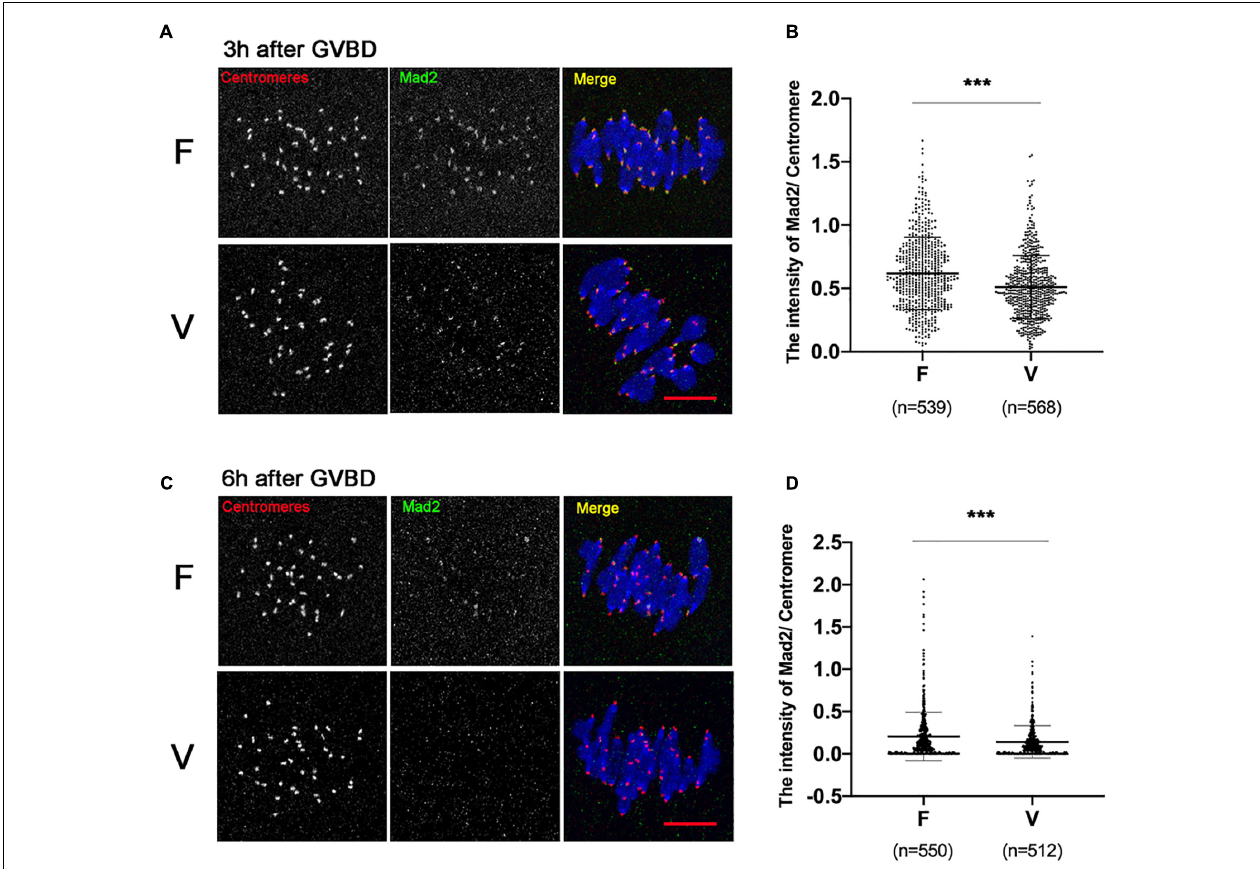
FIGURE 3 | The SAC was significantly decreased in vitrified oocytes at 6 h after GVBD. (A) 19 fresh oocytes and 19 vitrified oocytes were fixed at 3 h after GVBD to detect centromeres (Red), Mad2 (Green) and chromosomes (Blue). Scale bar: 10 µ m. (B) The intensity of Mad2/Centromere were quantified at 3h after GVBD. F, n = 539; V, n = 568, n : the number of the Centromere. (C) 18 fresh oocytes and 16 vitrified oocytes were fixed at 6 h after GVBD to detect centromeres (Red), Mad2 (Green) and chromosomes (Blue). Scale bar represents 10 µ m. (D) The intensity of Mad2/Centromere was quantified at 6 h after GVBD. F: n = 550; V: n = 512, n : the number of the Centromere. The experiments were replicated three times.